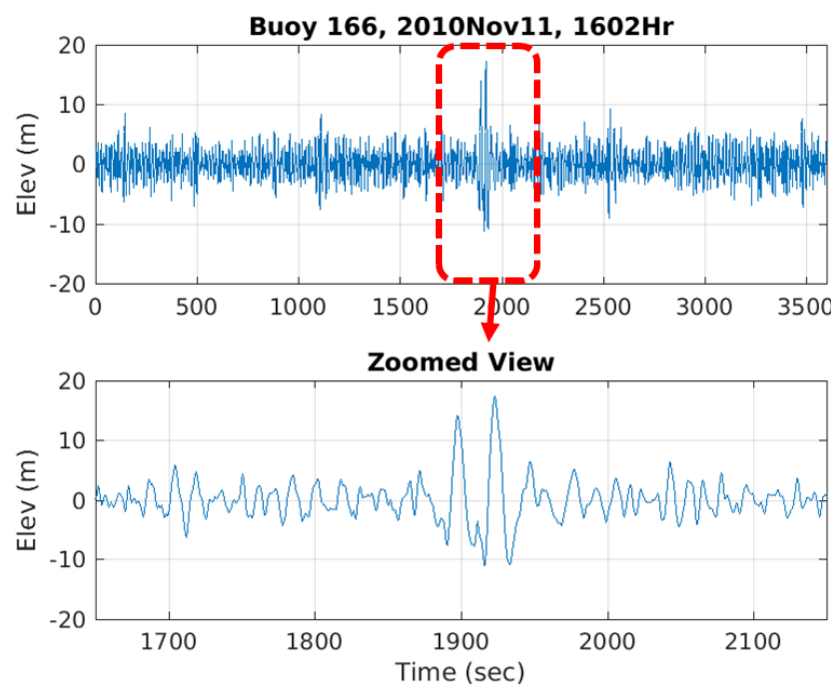
Figure 4. Top: Sample surface elevation time series from CDIP buoy 166, one hour of data beginning at 1602 UTC on Nov 11, 2010. Bottom: Zoomed view showing 500 s of data surrounding the 25.22 m rogue wave event. Ratio of H r /H s for the largest wave shown was 2.80.